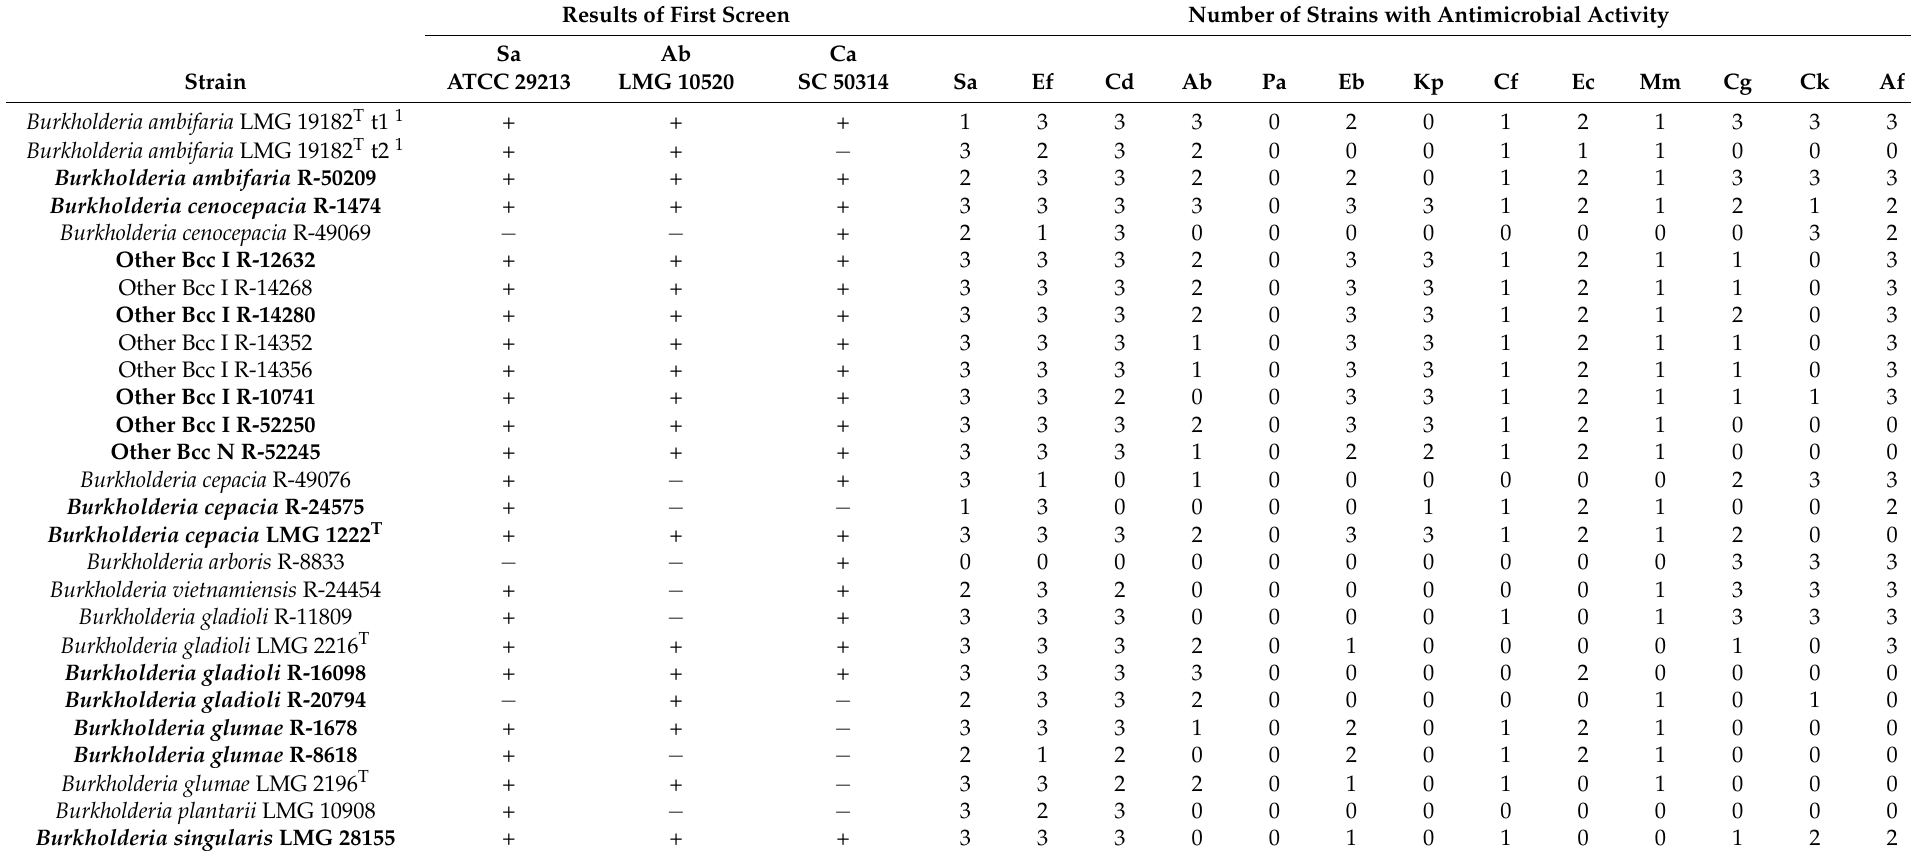
Table 2. Spectrum of antimicrobial activity of 27 Burkholderia isolates. Antimicrobial activity was defined as an inhibition zone diameter ≥ 5 mm. +, activity; − no activity; Sa, Staphylococcus aureus ; Ab, Acinetobacter baumannii ; Ca, Candida albicans ; Ef, Enterococcus faecium ; Cd, Clostridioides difficile ; Pa, Pseudomonas aeruginosa ; Eb, Enterobacter spp.; Kp, Klebsiella pneumoniae ; Cf, Citrobacter freundii ; Ec, Escherichia coli ; Mm, Morganella morganii; Cg, Candida glabrata ; Ck, Candida krusei ; Af, Aspergillus fumigatus . For all pathogens, three strains were tested, except for Ec (two strains), and Cf and Mm (one strain each). Isolates were assigned to Other Bcc groups by means of multilocus sequence typing analysis as described previously